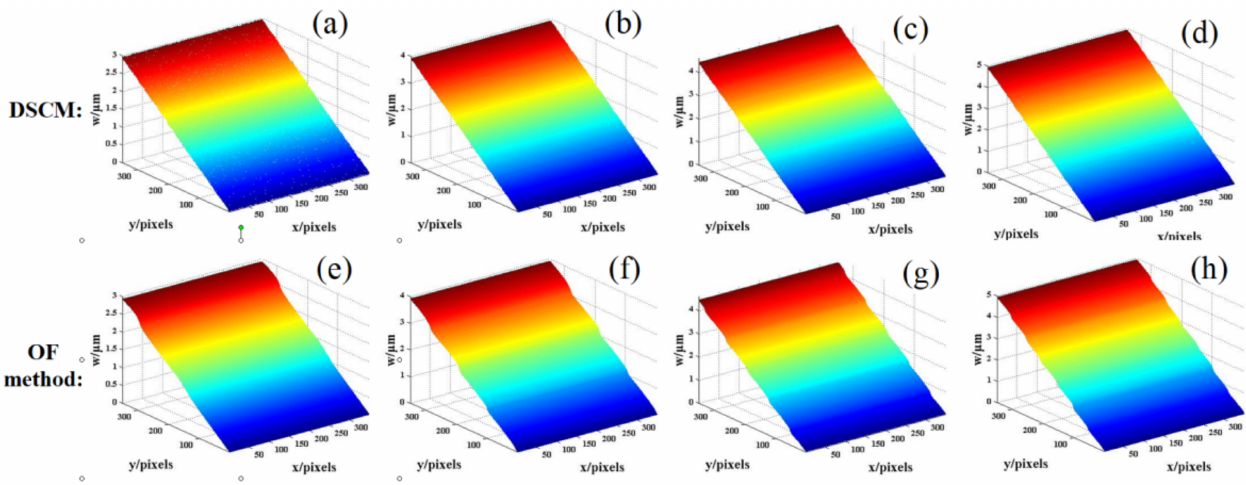
Figure 6. Experimental results by DSCM: ( a ) α = 6 ◦ ; ( b ) α = 8 ◦ ; ( c ) α = 9 ◦ ; ( d ) α = 10 ◦ ; and OF method: ( e ) α = 6 ◦ ; ( f ) α = 8 ◦ ; ( g ) α = 9 ◦ ; ( h ) α = 10 ◦